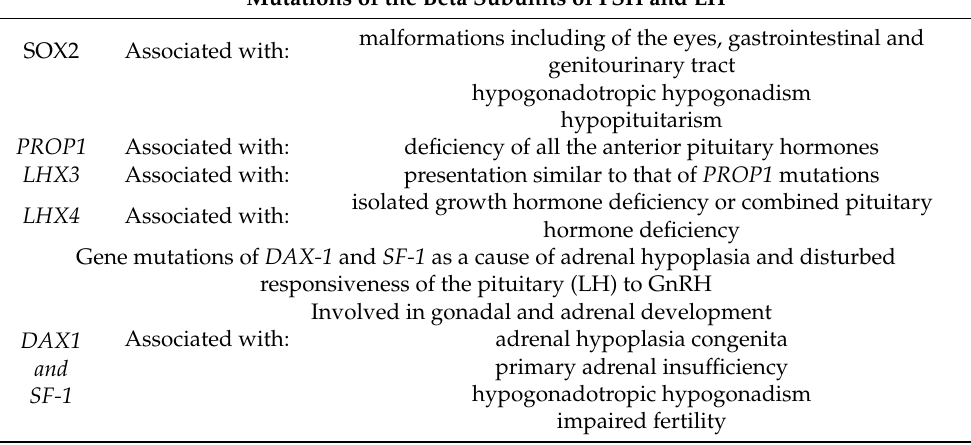
Table 1. Cont. Mutations of the Beta Subunits of FSH and LH malformations including of the eyes, gastrointestinal and SOX2 Associated with: genitourinary tract hypogonadotropic